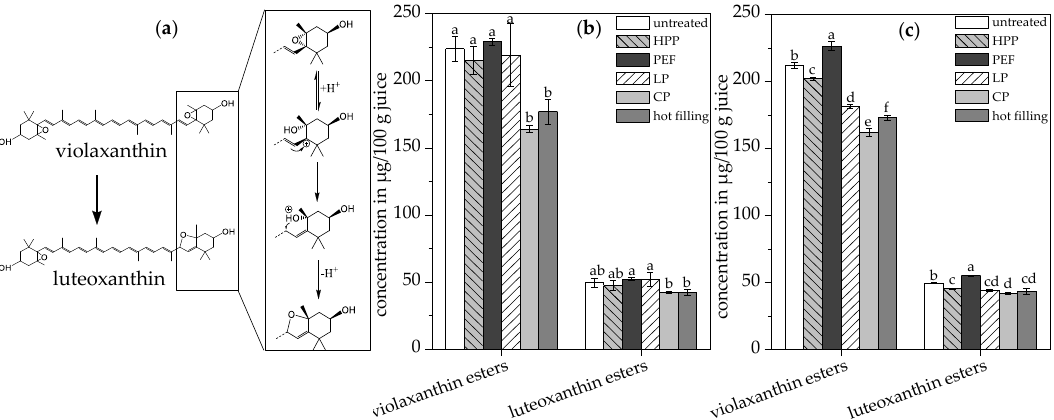
Figure 2. ( a ) Rearrangement of violaxanthin to luteoxanthin according to Schieber et al. [35]. Violaxanthin and luteoxanthin ester contents in the untreated and pasteurized juices without ( b ) and with ( c ) ultrasonication. Different letters indicate significant differences ( p ≤ 0.05). Values are means ± standard deviation ( n = 3).